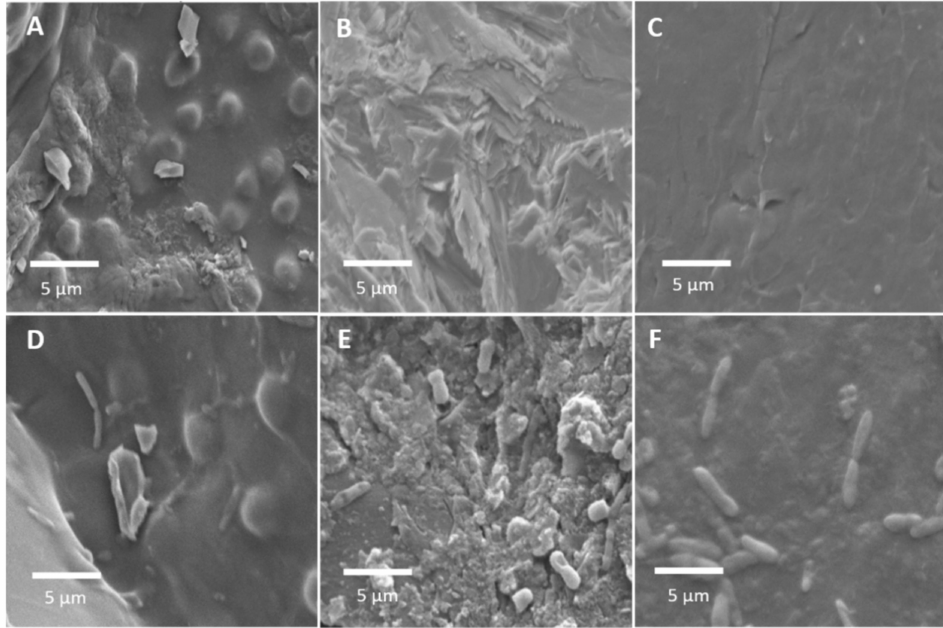
Figure 6. The SEM micrographs of the biofilter media in their pristine form as well as after the development of bacteria: biochar ( A , D ), zeolite ( B , E ), and plastic ( C , F